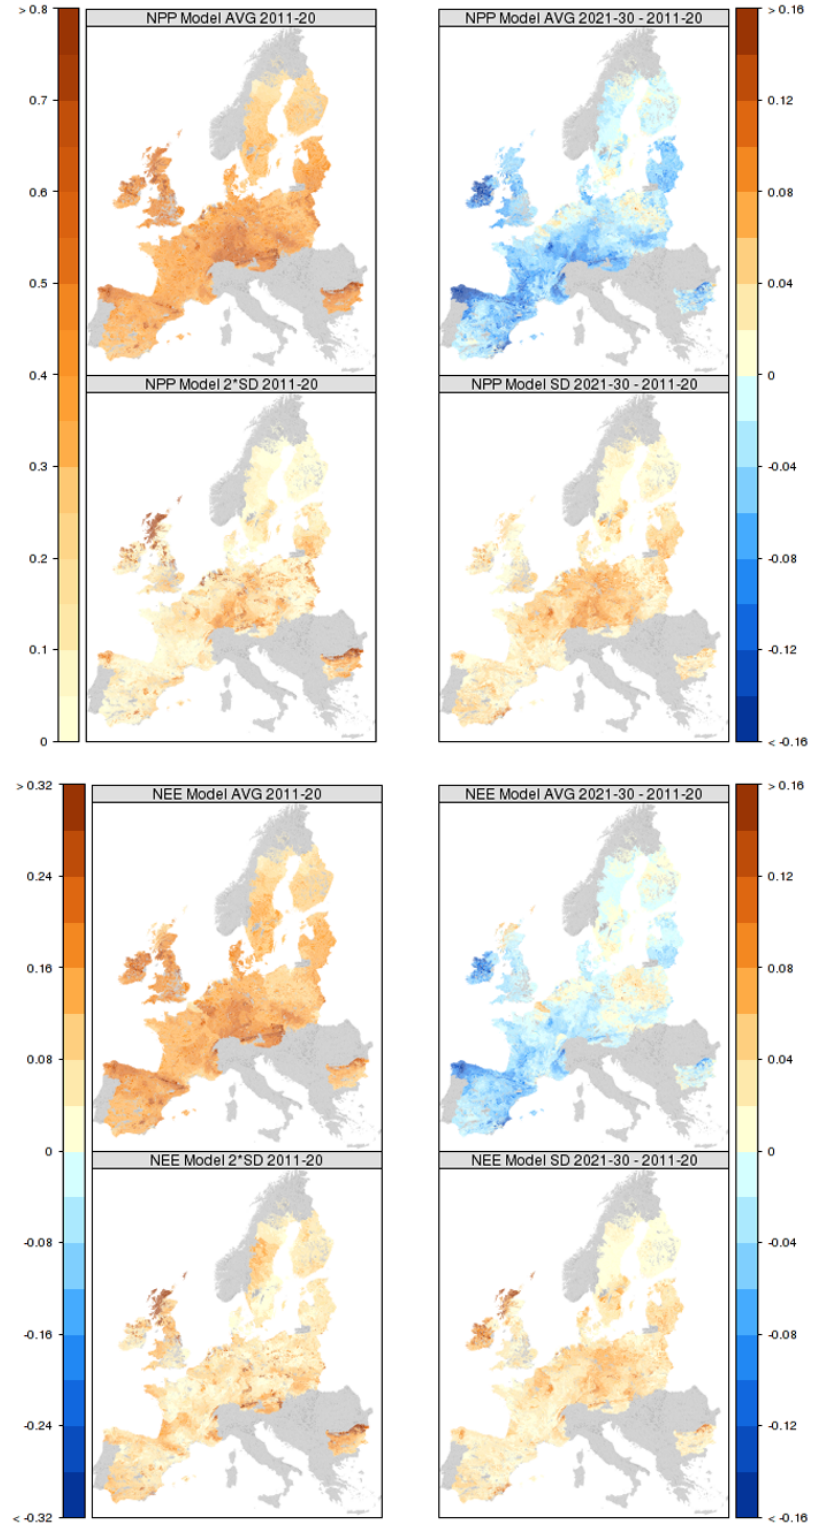
Fig. 3. NPP (top four plots) and NEE (bottom four plots) (kgCm − 2 yr − 1 ) for Scots pine. The first and third rows are averages over the models. The second and fourth rows are standard deviations (right column) or two times standard deviations (left column) over the models. The left column is the decadal average 2011–2020. The right column is the difference in decadal average 2021–2030 minus